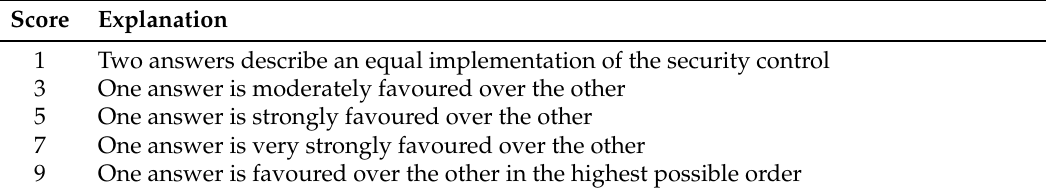
Table 9. Scores for Comparing Quality of Answers to CAIQ.